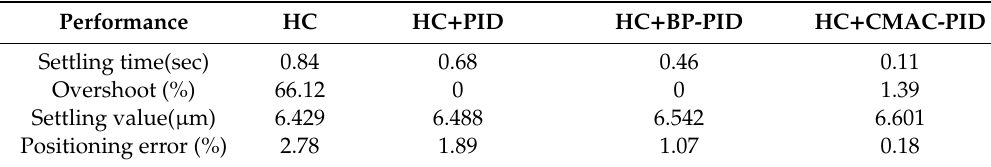
Figure 10. Close-loop response simulation of the micro-positioner. Table 2. Controller performance for compensation simulation.